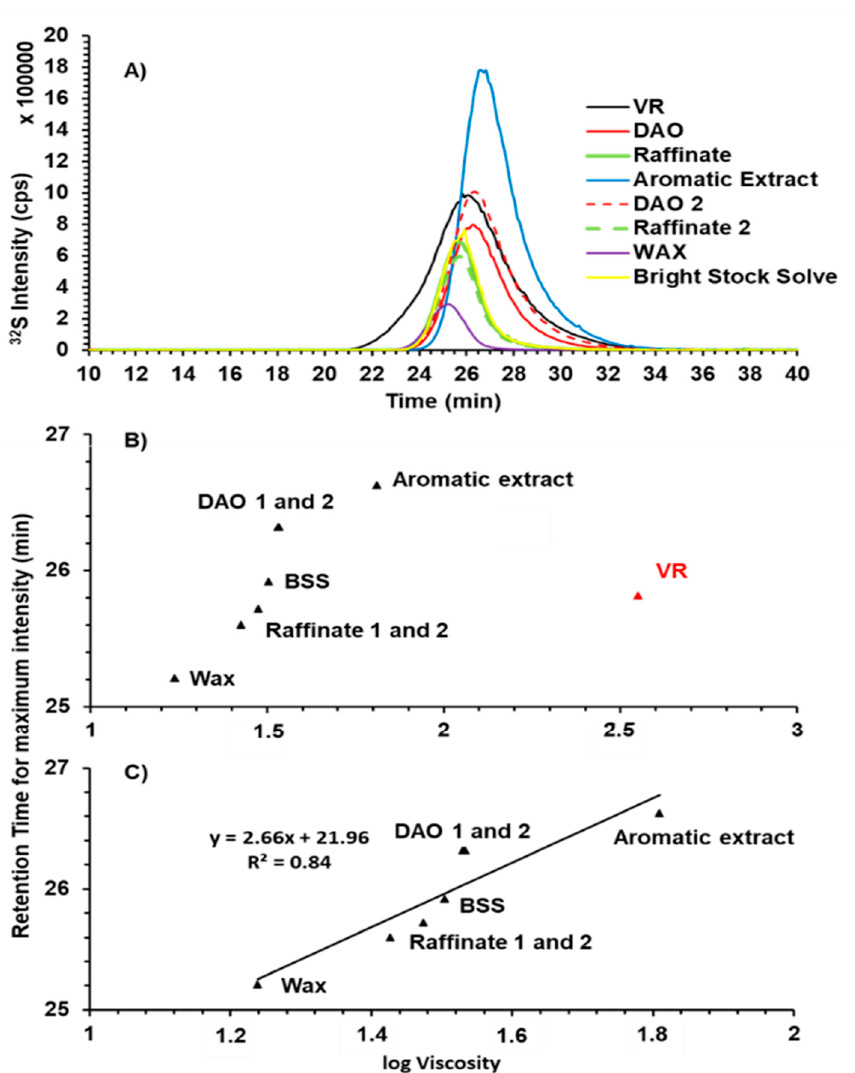
Figure 4. Chromatogram of sulfur containing molecules by GPC with inductively coupled plasma mass spectrometry (GPC-ICP HR MS) for all the samples ( A ). Retention time at the maximum intensity as a function of the log of viscosity for all the samples ( B ) and without VR ( C ). Abbreviations: GPC: gel permeation chromatography; ICP: inductively coupled plasma; MS: mass spectrometry Table 3. Retention time at maximum intensity and at 10% maximum intensity for 32 S obtained by GPC-ICP HR MS for each sample.